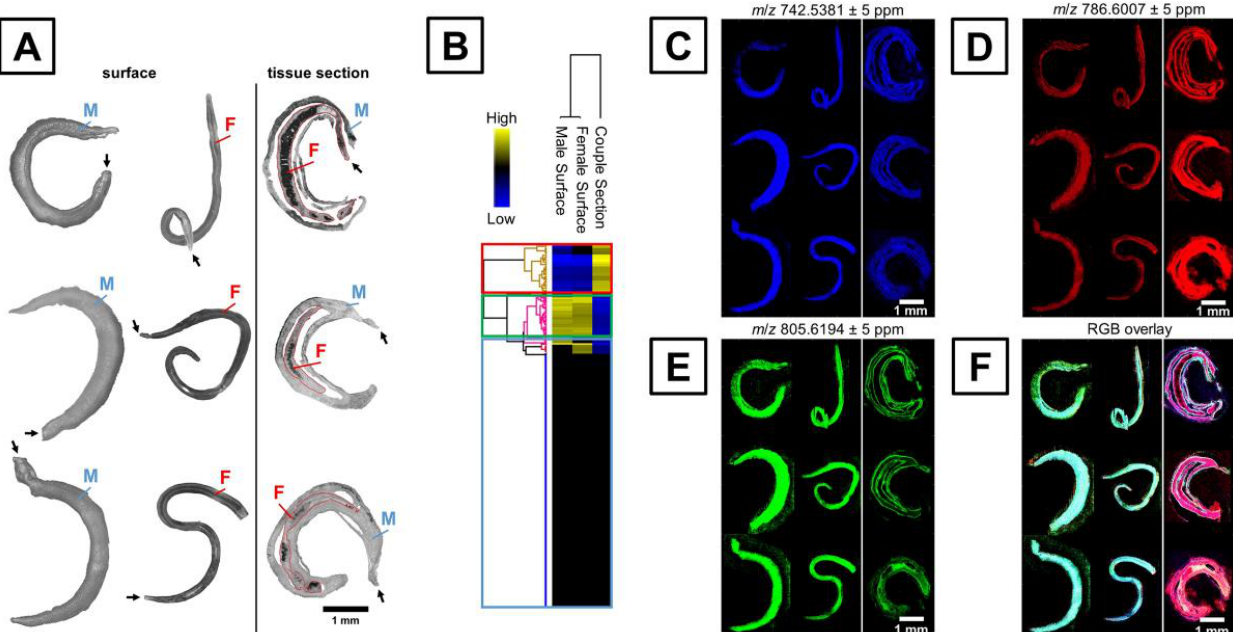
Figure 5. Light Microscopic and MALDI-MSI analysis of male (M) and female (F) S. mansoni tegument surface-associated lipids. Figure was reproduced from Kadesch and colleagues’ work [99].